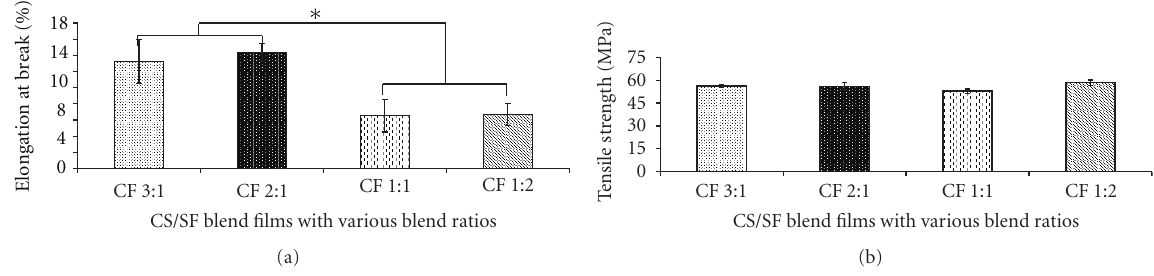
Figure 4: Mechanical properties of CS/SF blend films with various blend ratios of chitosan :fibroin (CF) at dry state; (a) % elongation at break and (b) tensile strength. Each bar represents mean ± standard error ( n = 3). One-way ANOVA showed a significant di ff erence in percent remaining weight among groups ( ∗ P < 0 . 05).